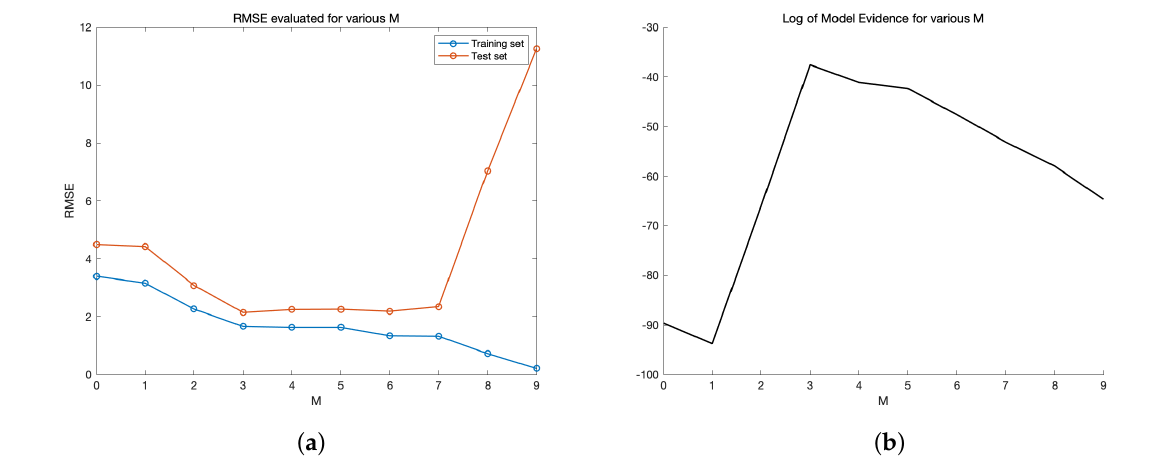
Figure 3. ( a ): Graphs of the root-mean-square error (RMSE) evaluated on the training set and independent test set for various values of M. ( b ): Plot of a model evidence for various values of